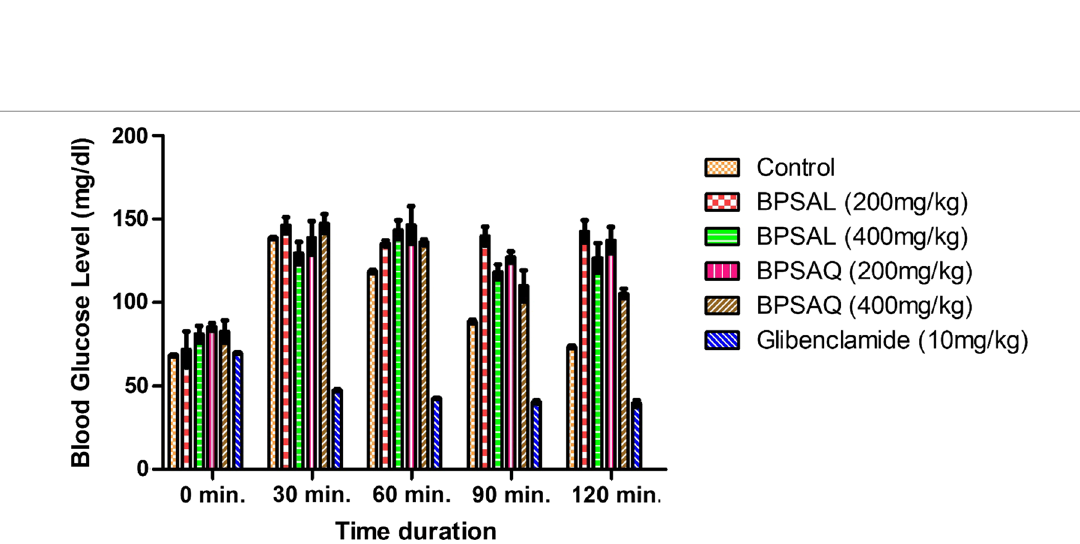
Fig. 10 OGTT results of BPSAL and BPSAQ on FBG. Values are expressed as Mean